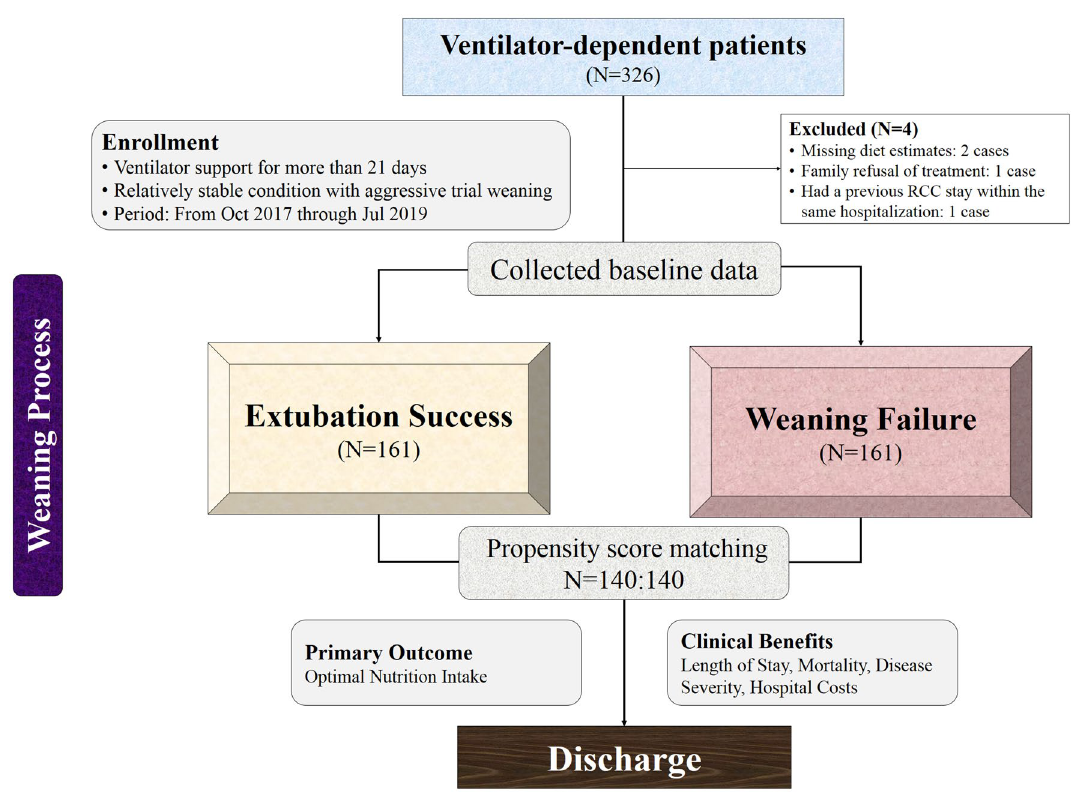
Figure 1. Enrollment flowchart and study